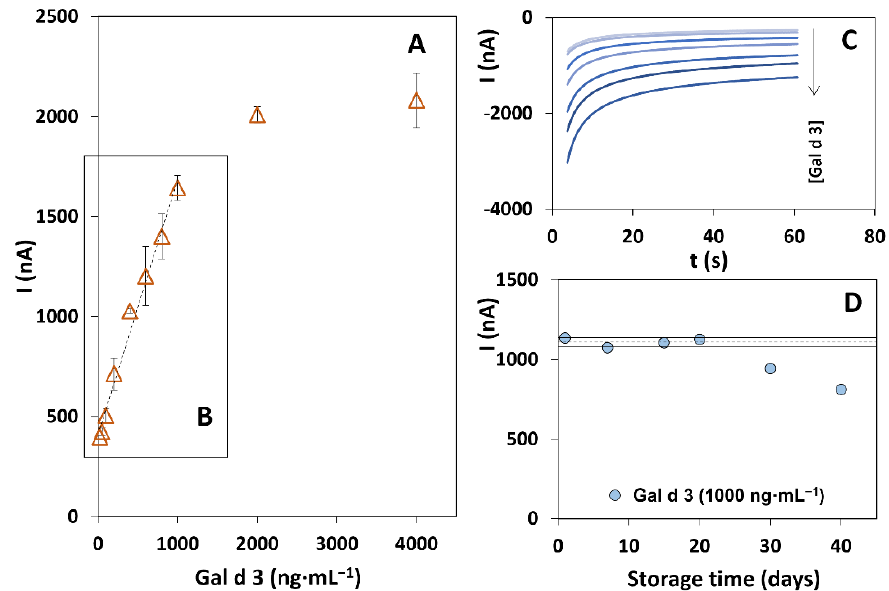
Figure 3. ( A ) Results of the analysis of Gal d 3 between 50 and 4000 ng · mL − 1 , ( B ) Calibration straight for Gal d 3 (55 – 1000 ng·mL − 1 ), and ( C ) respective amperograms. ( D ) Results of the stability study (dashed line: mean values ( x ), solid lines: sum of mean and standard deviation ( n = 3, x ± ϕ ) of a set of measurements performed over 40 days). Other experimental parameters: chronoamperometry: 0 V, 1 min.